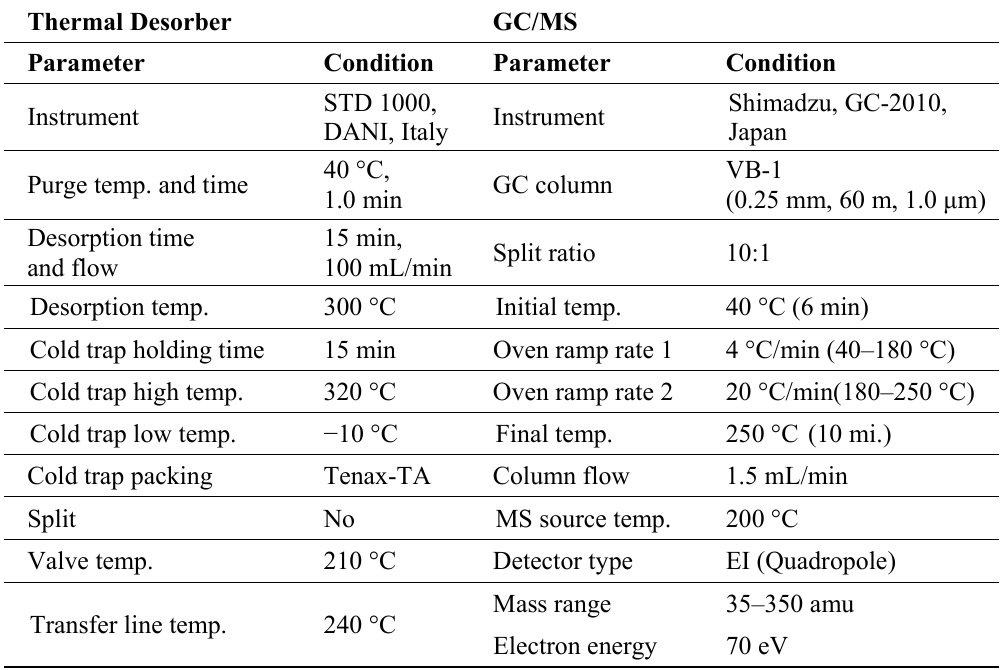
Table 3. Conditions for VOC analysis using the GC/MS.